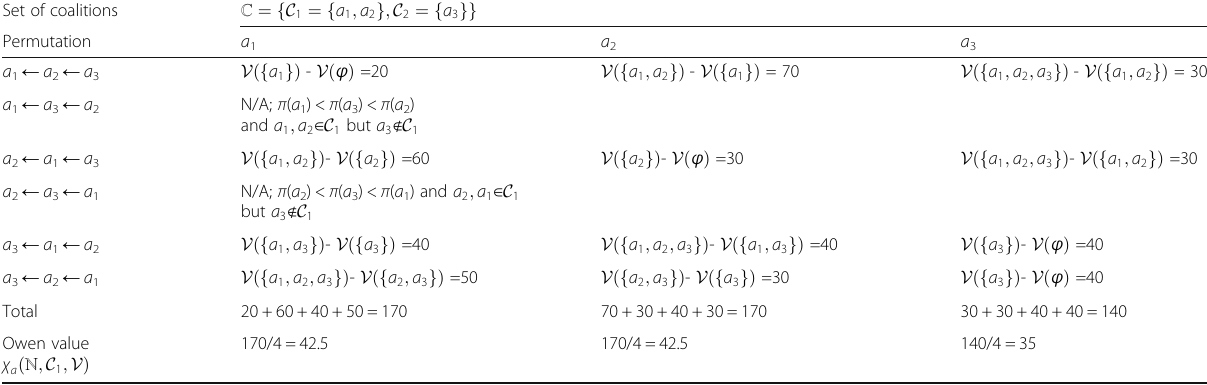
Table 1 Example of the computation of the Owen value Set of